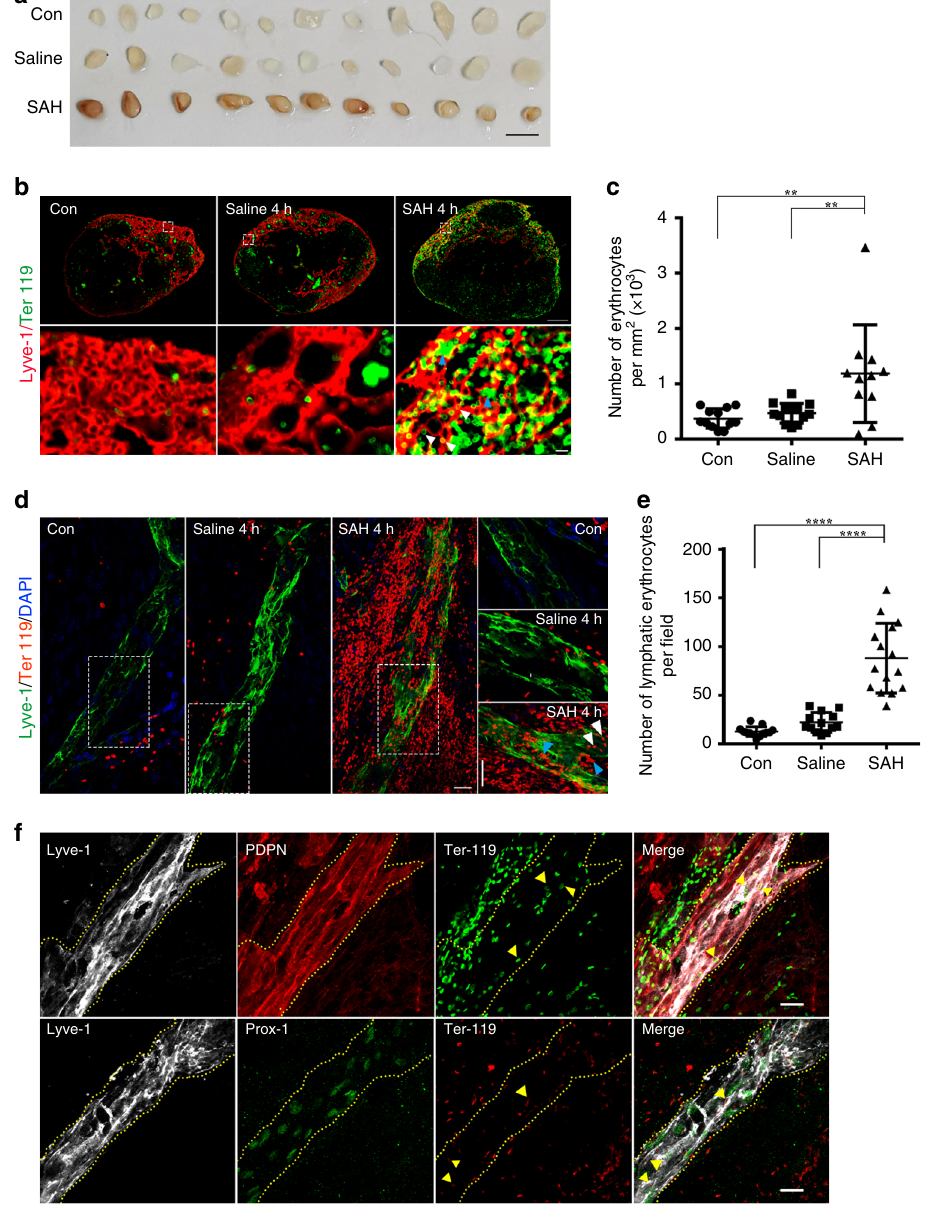
Fig. 1 The erythrocytes in the cerebrospinal fl uid after subarachnoid hemorrhage (SAH) were drained into deep cervical lymph nodes (dCLNs) via meningeal lymphatics. a Isolated dCLNs from mice 4 h after autologous blood (SAH) or saline injected into the cisterna magna (i.c.m.) or blank control group (Con). Scale bar, 2 mm. b Representative images of dCLNs isolated 4 h post-induction of the SAH, saline, and Con groups, stained for Lyve-1 (to image lymphatics, red) or Ter119 (to image erythrocytes, green). Regions of interest in the top images are shown below. White arrows, morphologically intact erythrocytes. Blue arrows, clusters of degraded membrane. Scale bars 200 μ m (for top images) and 10 μ m (for bottom images). n = 3 independent experiments. c The number of erythrocyte per mm 2 in the Lyve-1-positive lymphatic sinus of dCLNs from the SAH, saline, and Con groups. Con/Saline; n = 12, SAH; n = 11 mice, pooled from 3 independent experiments. P (Con vs SAH) = 0.002; P (Saline vs SAH) = 0.0063. d Representative image of the meningeal lymphatics (green) on transverse sinus (TS) draining the erythrocytes (red) after 4 h of SAH, compared with the Con and saline groups. Regions of interest in the left images are shown on the right. White arrows, morphologically intact erythrocytes. Blue arrows, clusters of degraded membrane. Scale bar, 20 μ m (the left and right images). n = 3 independent experiments. e Quanti fi cation of the number of erythrocytes per fi eld accumulated into lymphatics on TS. Con/Saline; n = 13, SAH; n = 15 biologically independent animals, pooled from 3 independent experiments. P (Con vs SAH) < 0.0001; P (Saline vs SAH) < 0.0001. f The expression of classical lymphatic endothelial cell markers by the meningeal lymphatic vessels co-stained with erythrocytes. Representative images of podoplanin (PDPN, red) and Lyve-1 (gray) expressing vessels co-localized with erythrocytes (green) (top images). Representative images of Prox1 (green) and Lyve-1 (gray) expressing vessels co-localized with erythrocytes (red) (bottom images). Yellow arrow, erythrocytes inside the meningeal lymphatic vessels. Scale bar, 20 μ m. n = 2 independent experiments. All data are presented as mean values ± SD; one- way ANOVA with Turkey ’ s multiple-comparison test. ** P < 0.01, **** P < 0.0001. Source data are provided as a Source data fi